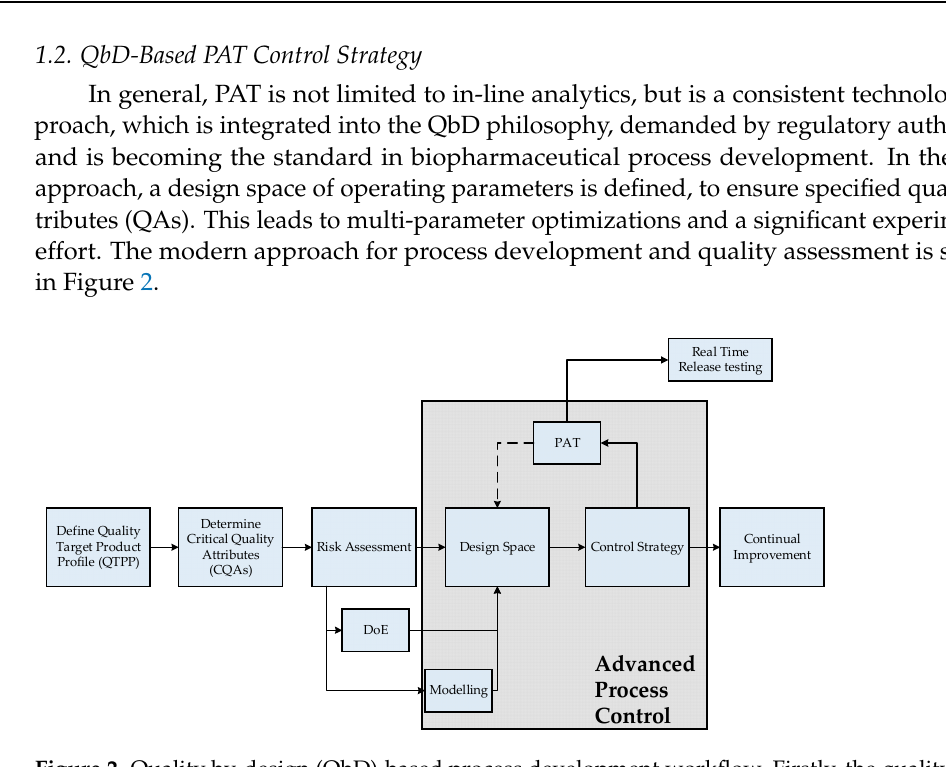
Figure 2. Quality by-design (QbD)-based process development workflow. Firstly, the quality